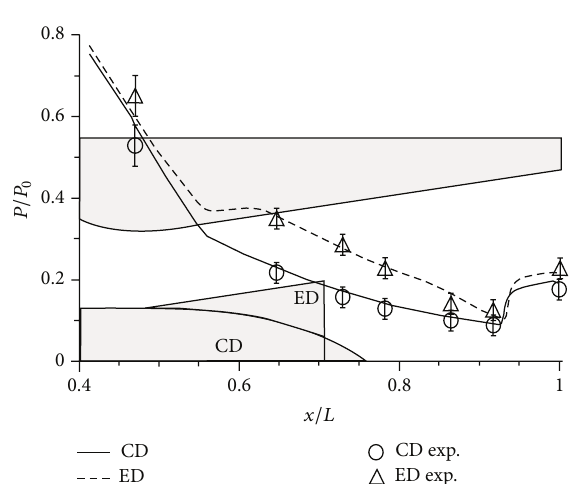
Figure 10: Comparison of pressure distributions in the GOX flow condition.